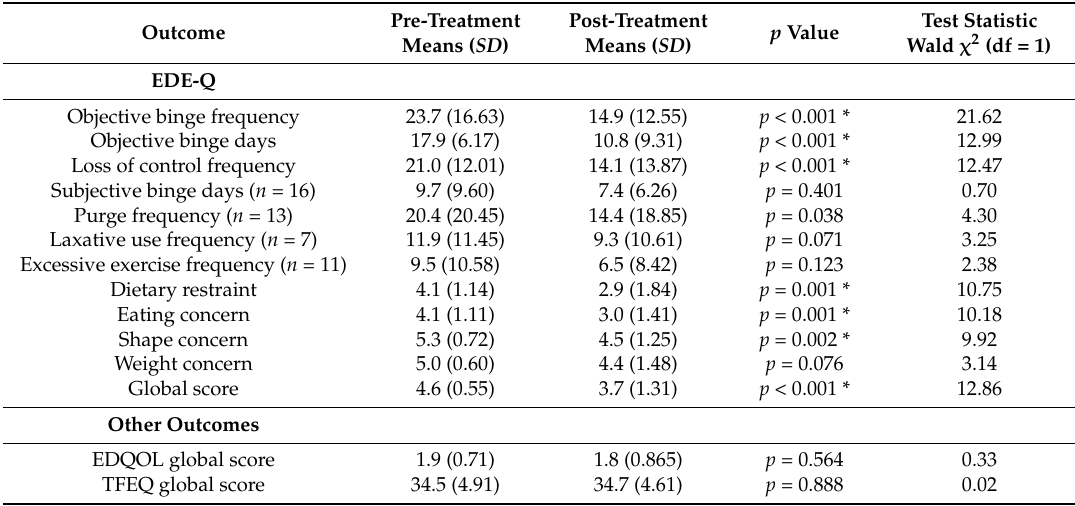
Table 2. Treatment outcomes for Eating Disorder Examination-Questionnaire (EDE-Q), Eating Disorder Quality of Life Scale (EDQOL) and Three Factor Eating Questionnaire (TFEQ) Scores ( n =